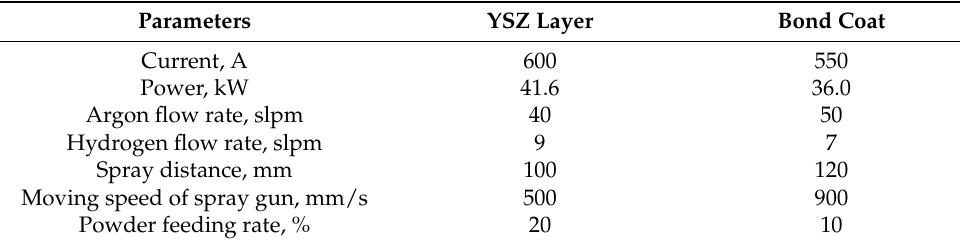
Table 1. Process parameters of TBC preparation.